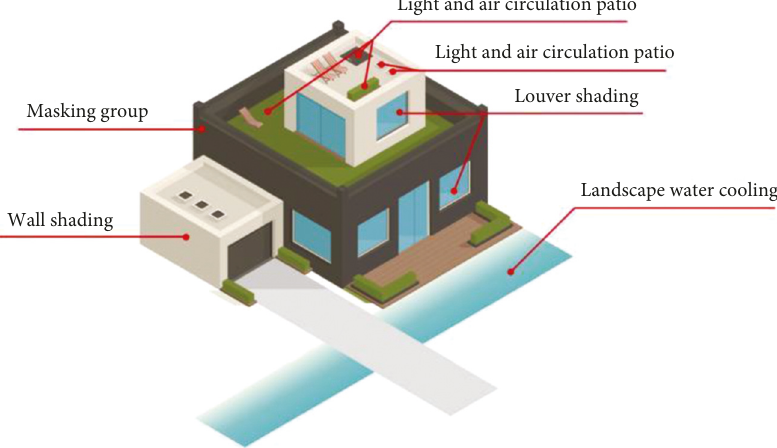
Figure 1: Sketch map of green technology